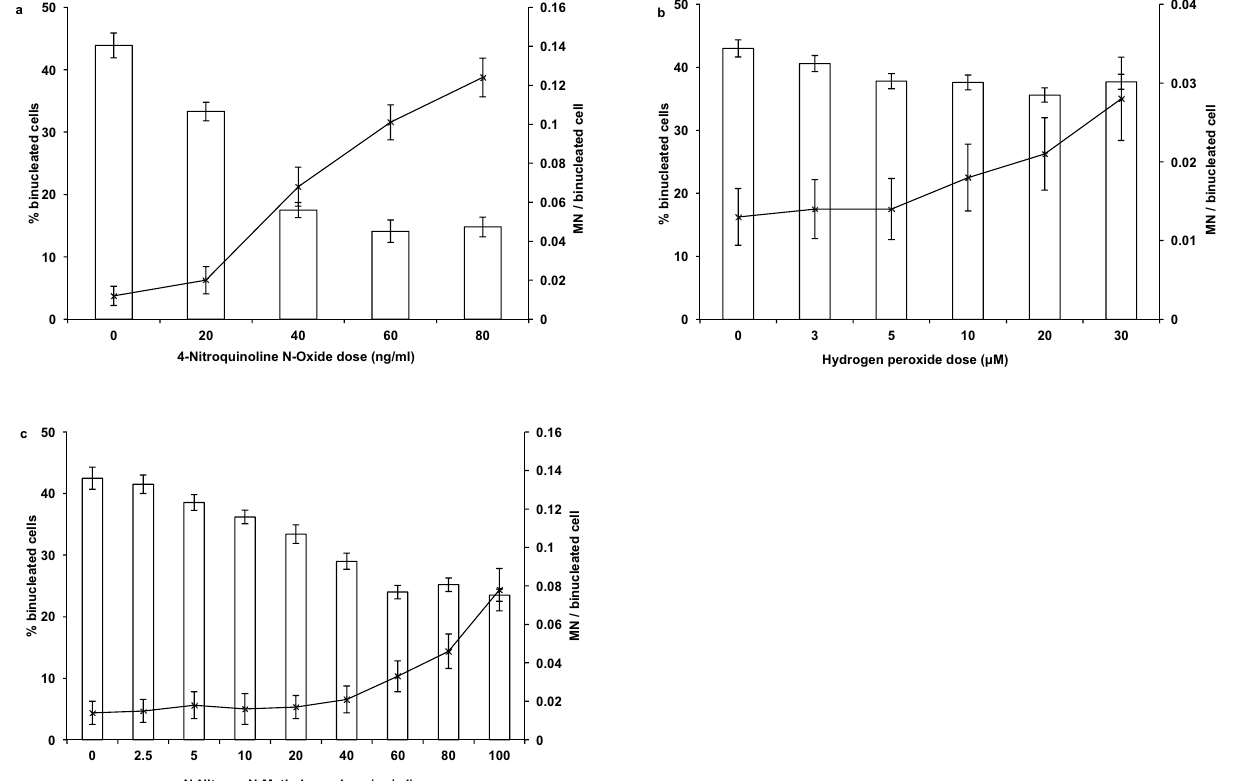
Figure 1. Percentage of binucleated cells (columns) and yield of micronuclei per 100 binucleated cells (‘x’ marker connected by line) following 24 h 4NQO exposure of GM1899A cells ( a ), 24 h H 2 O 2 exposure of GM1899A cells ( b ), and 24 h MNU exposure of GM1899A cells ( c ). Results are from one experiment, with 200–500 binucleated cells on two slides scored for each dose ( a ) or 500 binucleated cells on two slides scored for each dose ( b , c ). Error bars represent Poisson